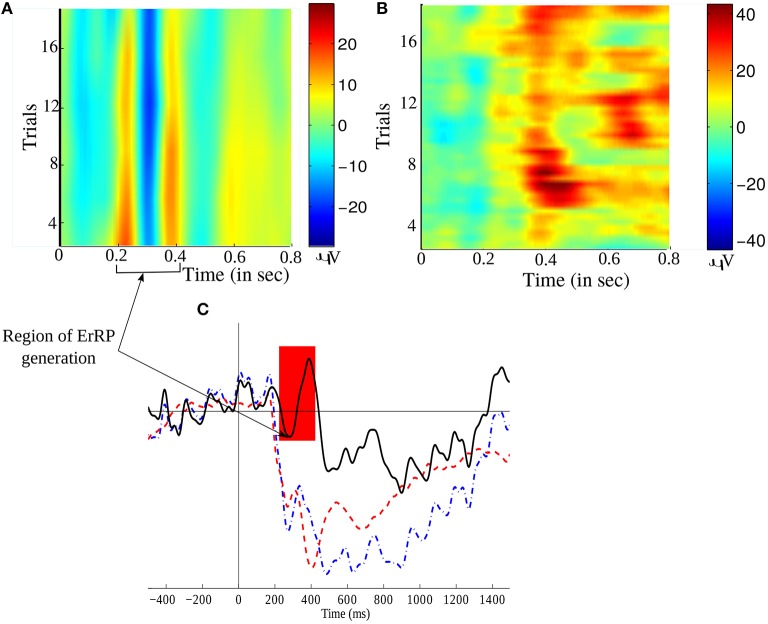
Time-trial representation of (A) error related EEG signal, and (B) No error related EEG signal, over all trials. (C) A comparison of the grand averaged ErrP (in black –), non-ErrP (in blue –.) and their difference signals (in red –) from channel Cz. The shaded region marks the occurrence of the typical ERN waveform.